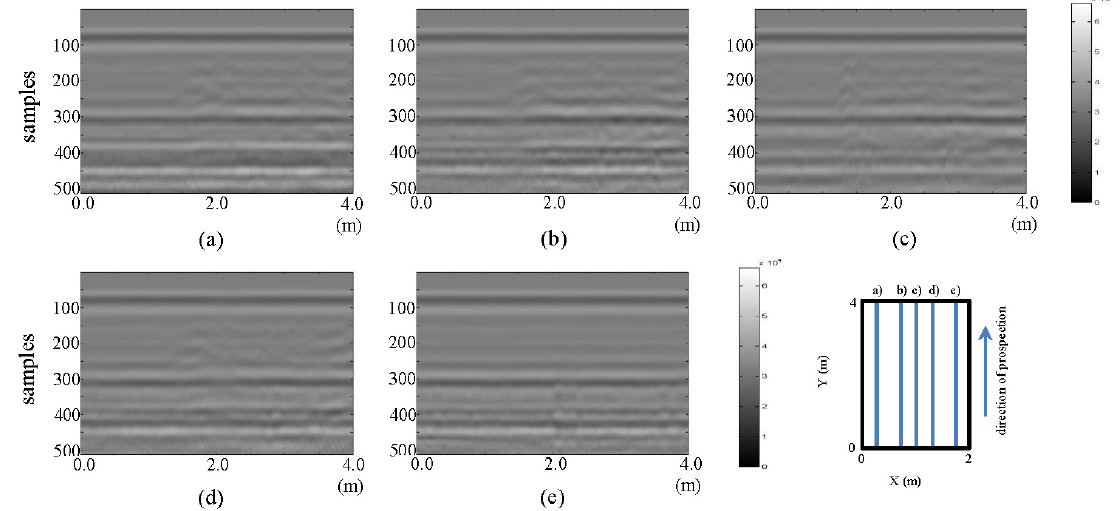
Figure 23. Vertical profiles: raw images. ( a – e ) are profiles sf9 to sf13, respectively.